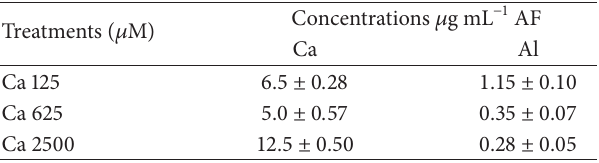
Table3:CalciumandAlconcentrationsintheapoplasticfluidofthe roots treated with 100 𝜇 M Al for 6 d (H2). The wheat seedlings were pretreated with different levels of Ca for 14d before Al treatment. Values are means ± SE of three